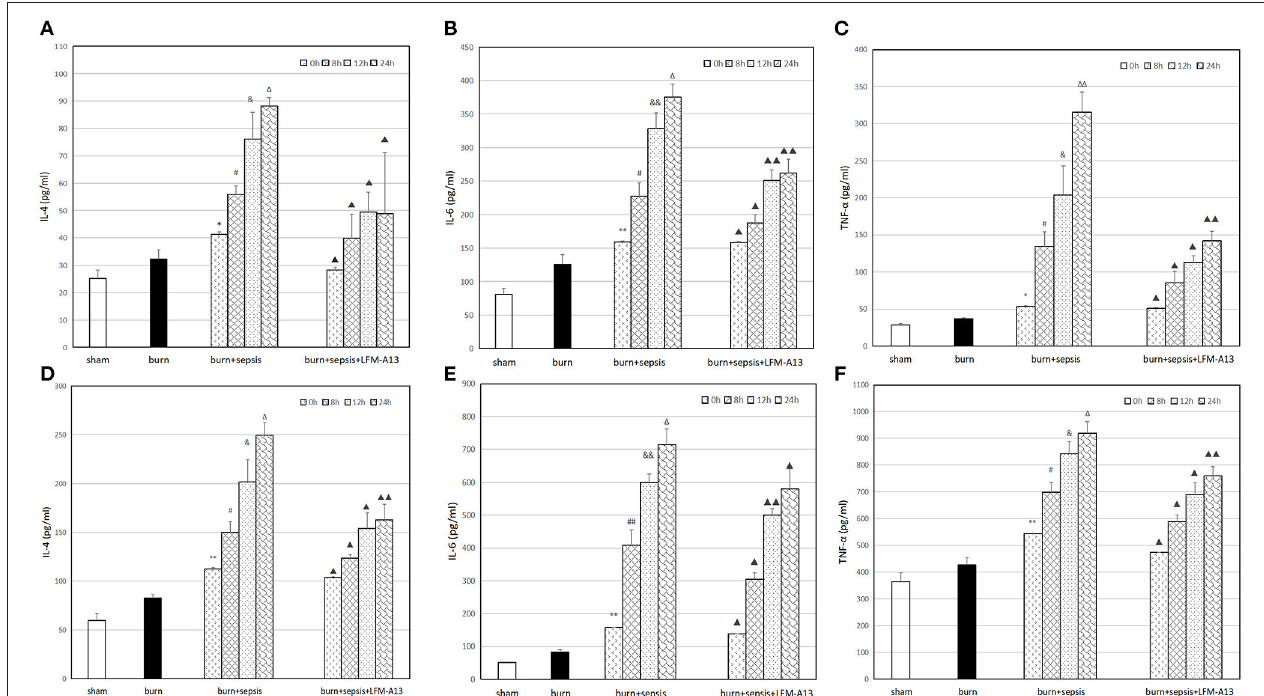
FIGURE 4 | Levels of IL-4, IL-6, and TNF- α in serum and intestinal tissue. (A–C) : Levels of IL-4 (A) , IL-6 (B) , and TNF- α (C) levels in serum at different time points in each group. ** P < 0.01 (A,B) , * P < 0.05 (C) , vs. the sham group and burn group; in the burn + sepsis group, P < 0.05, # P < 0.05 (A) , # P < 0.05 (B,C) vs. 0h, & P < 0.05 (A) , && P < 0.01 (B) , & P > 0.05 (C) vs. 8h, 1 P > 0.05 (A,B) , 11 P < 0.01 (C) vs. 12h; N P < 0.05, NN P < 0.01 vs. the burn + sepsis group at corresponding time points except 0h postburn. (D–F) : Levels of IL-4 (D) , IL-6 (E) and TNF- α (F) levels in intestinal tissue at different time points in each group. ** P < 0.01, vs.